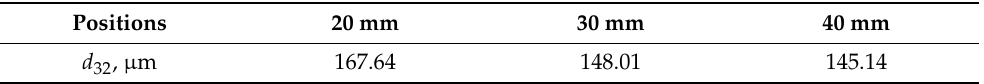
Table 7. Average particle diameter of SCS1-1 atomization field in different